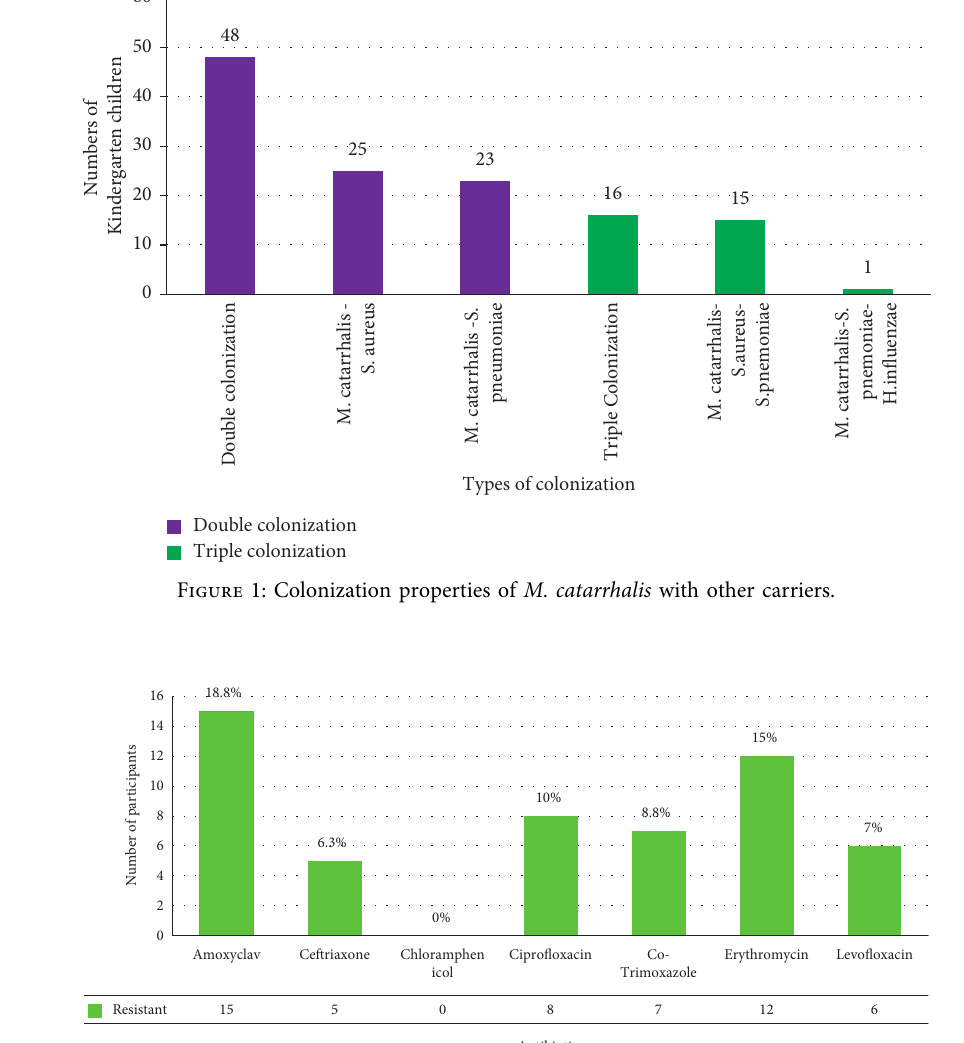
Figure 2: Antimicrobial resistance pattern of M.